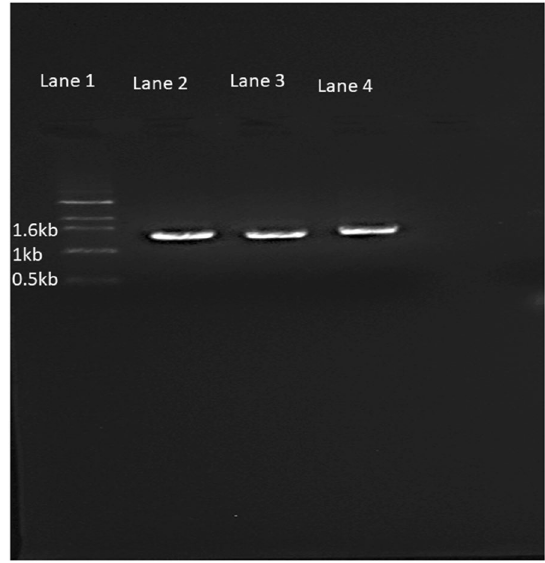
Fig. 5 PCR product analysis of 16S rRNA (1500bp) gene from LDPE-degrading bacteria, lane 1, 1kb DNA ladder; lane 2, KS 35; lane 3, KS 119; and lane 4, KS14